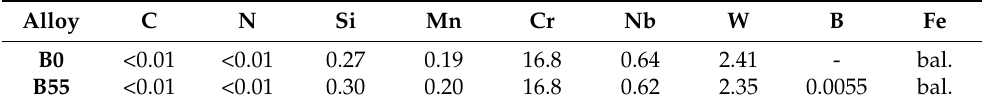
Table 1. Chemical composition in wt. % of the investigated alloys.